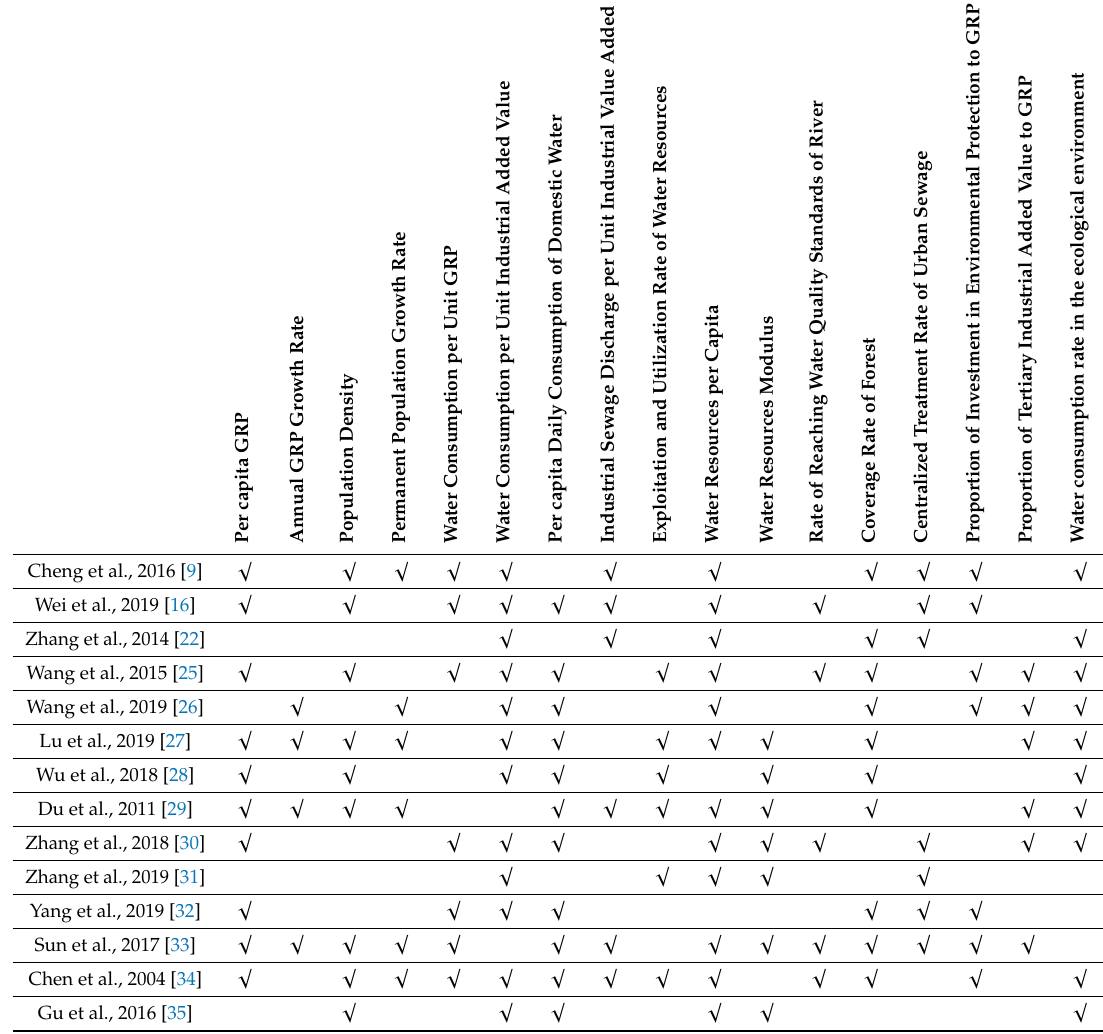
Table 1. Source of partial carrying capacity evaluation